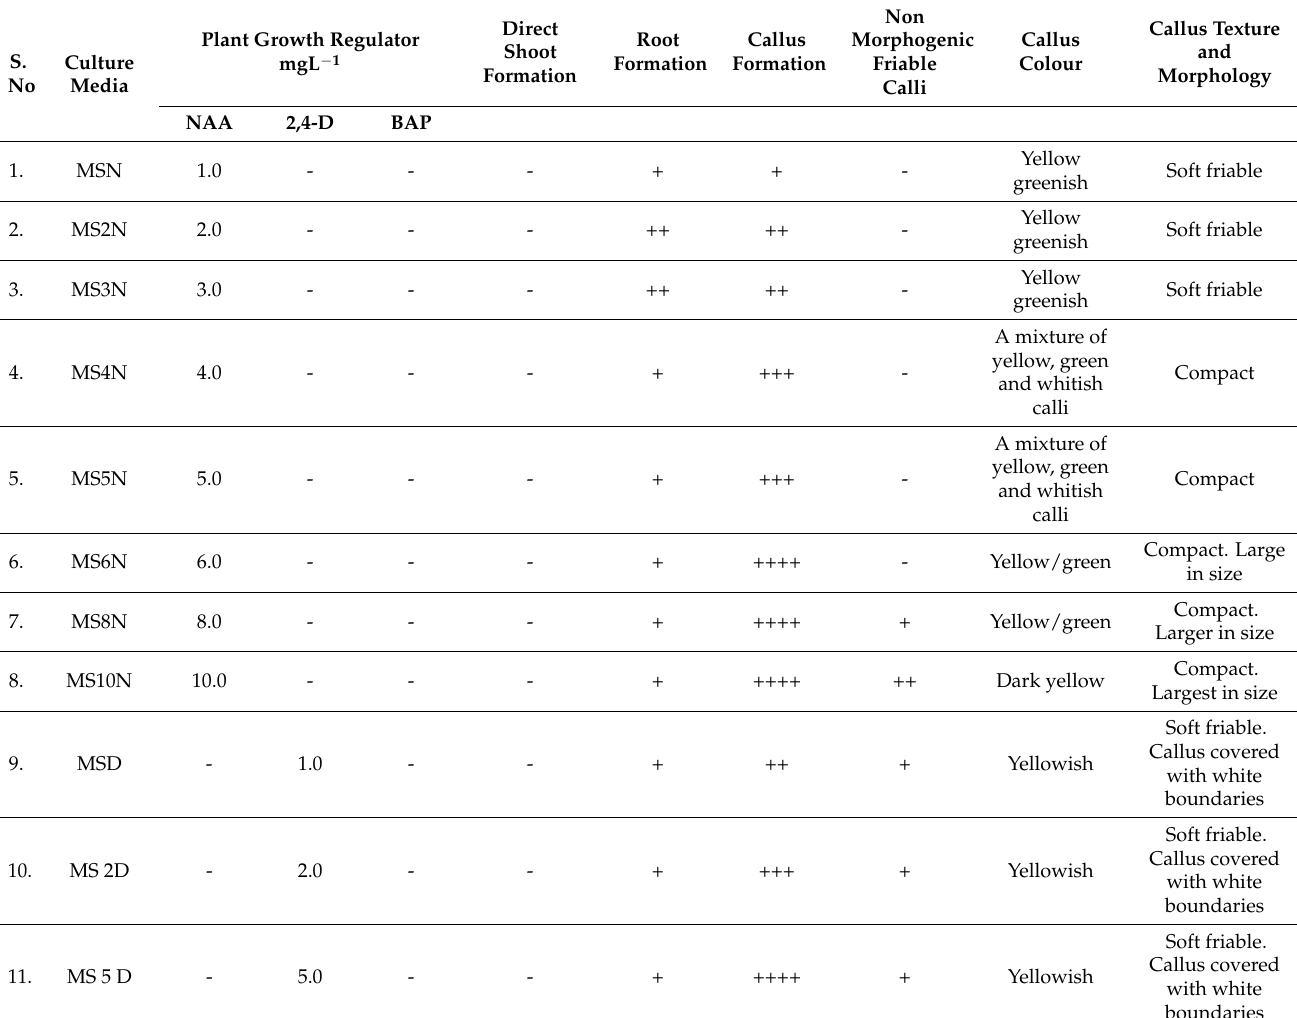
Table 1. Initial responses of immature and mature embryonic axis and cotyledon cultured on MS medium supplemented with different plant growth regulators in varying